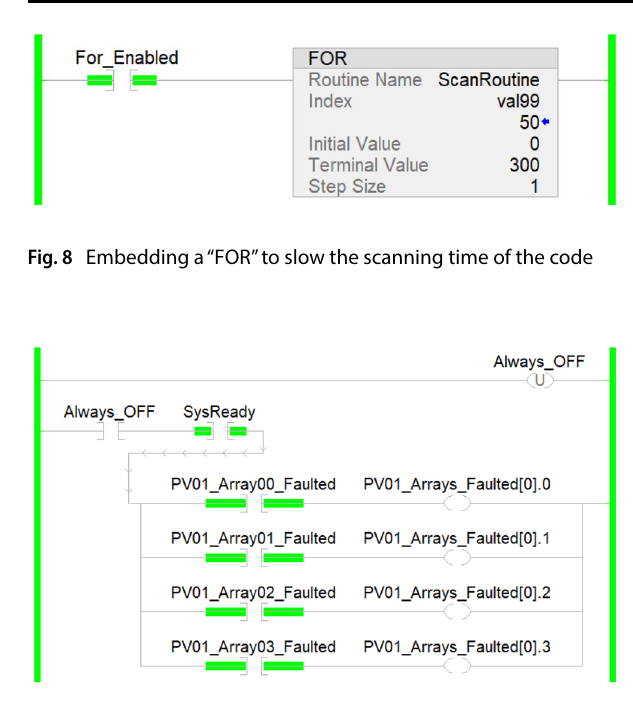
Fig. 9 Faults were deactivated when ANDed with a false bit